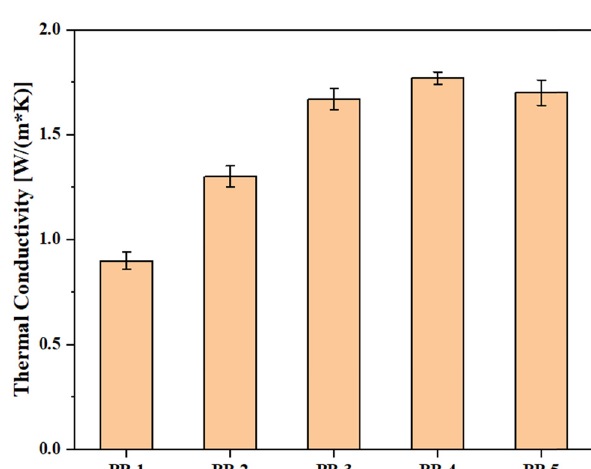
Figure A1: E ff ect of di ff erent EG and Al 2 O 3 ratios on thermal con - ductivity of PP composites.